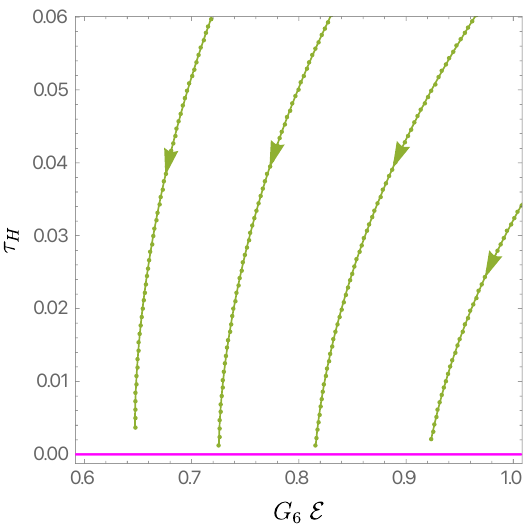
Figure 7 . τ H as a function of E for several of the solutions in figure 6 that approach extremality. The direction of the arrows indicates decreasing values of ∆ J in figure